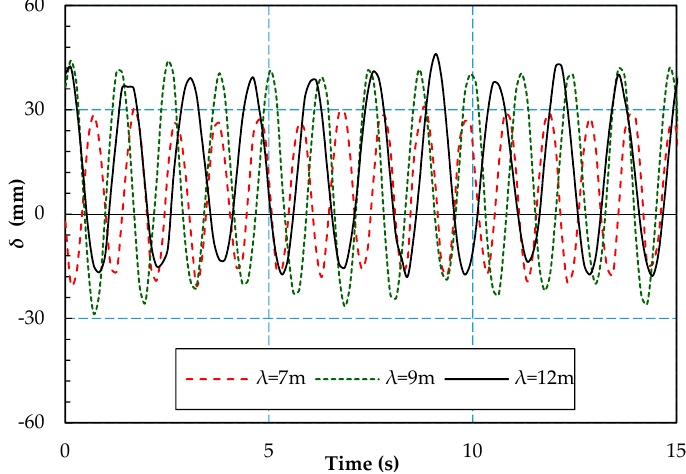
Water 2019 , 11 , x FOR PEER REVIEW Figure 14. Oscillation curves of heave in different wavelengths. Figure 14. Oscillation curves of heave in different wavelengths.